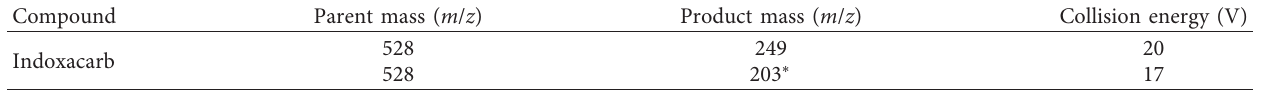
Table 2: SRM conditions for indoxacarb.